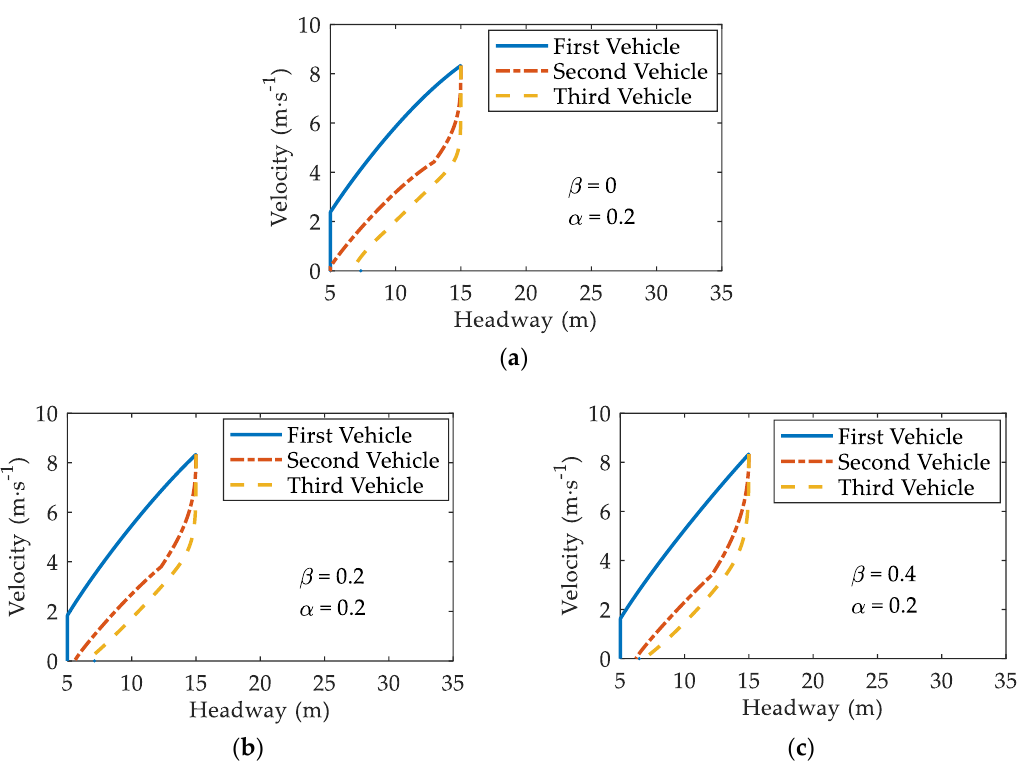
Figure 5. Three trajectories for three vehicles behind the suddenly stopped vehicle under different β : ( a ) β = 0; ( b ) β = 0.2; ( c ) β = 0.4, where α = 0.2, T = 1.2